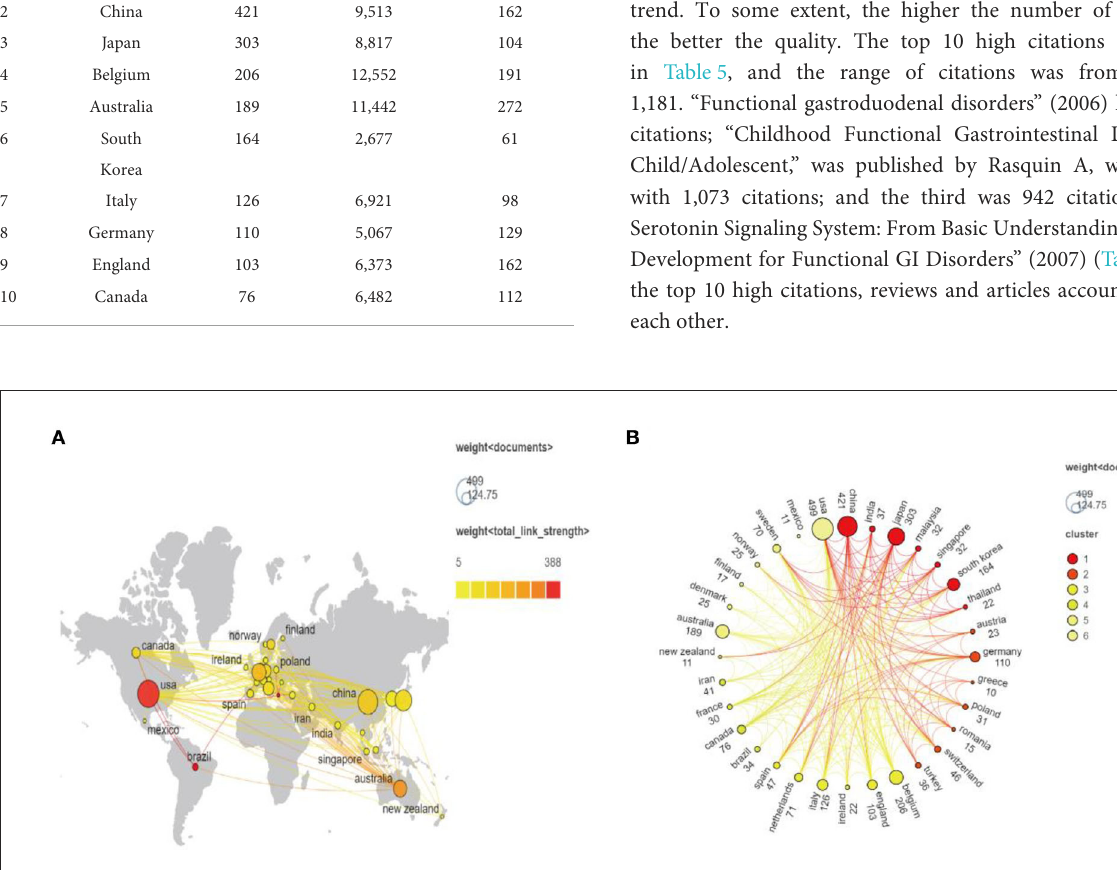
FIGURE5 Co-occurrence of countries on FD. (A) A world map showing the number of publications and the strength of collaborations among countries. (B) A circle diagram that evaluates international collaboration between